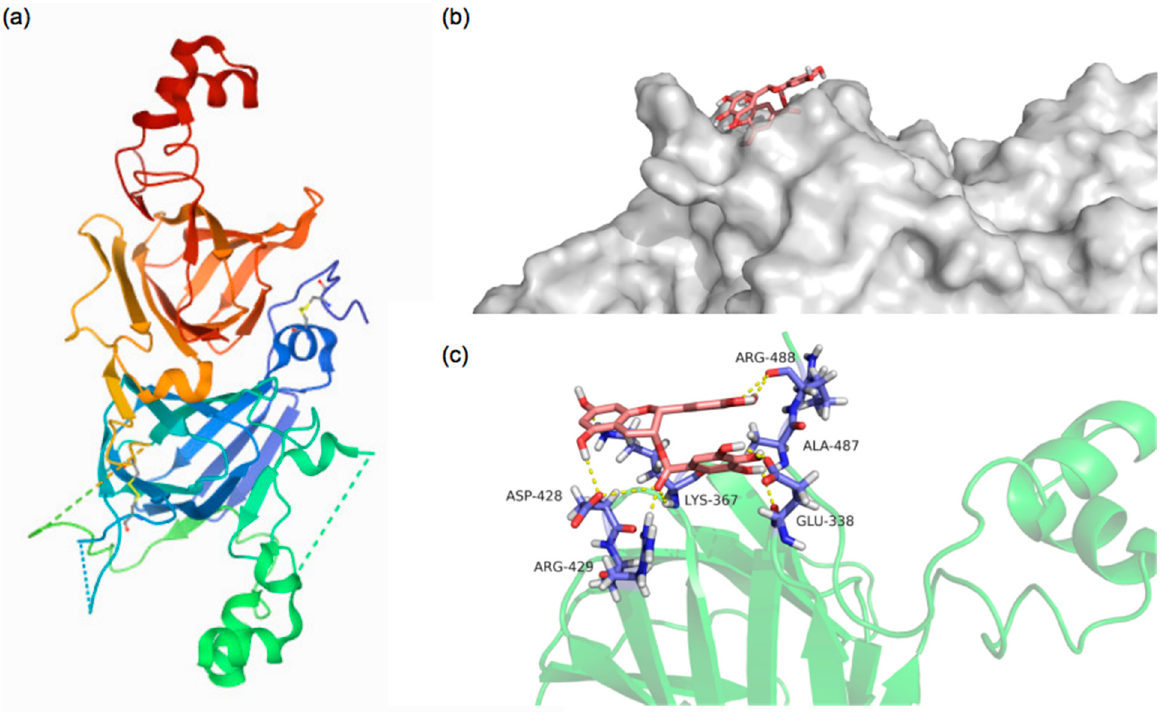
Figure 7. The 3D structure of Entity 1 in the PPI ( a ). The best docked surface structure ( b ) and the best docked conformation ( c ) for the complex of PPI with EGCG. The pink stick structure expresses the catechins, the purple stick represents the amino acids residues, and the yellow dotted line represents hydrogen-bonding.